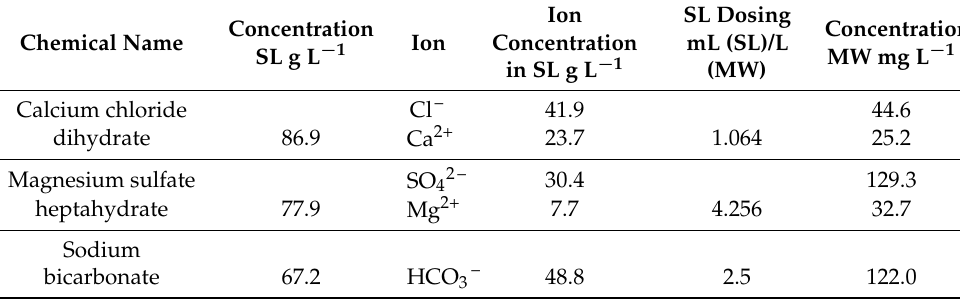
Table 5. B. Test water for hardness medium—Experiment no.2.